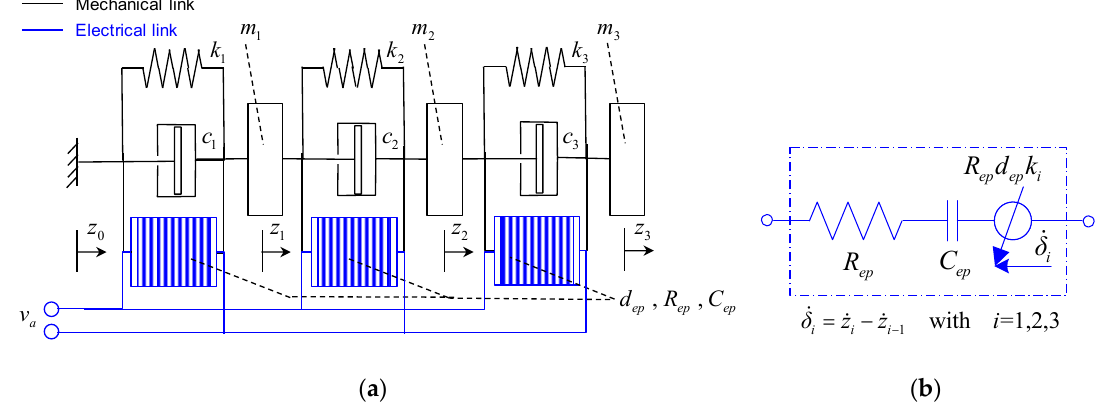
Figure 5. Lumped-parameters schematization: ( a ) complete prototype; ( b ) i -th patch.